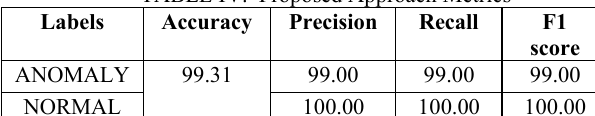
TABLE IV. Proposed Approach